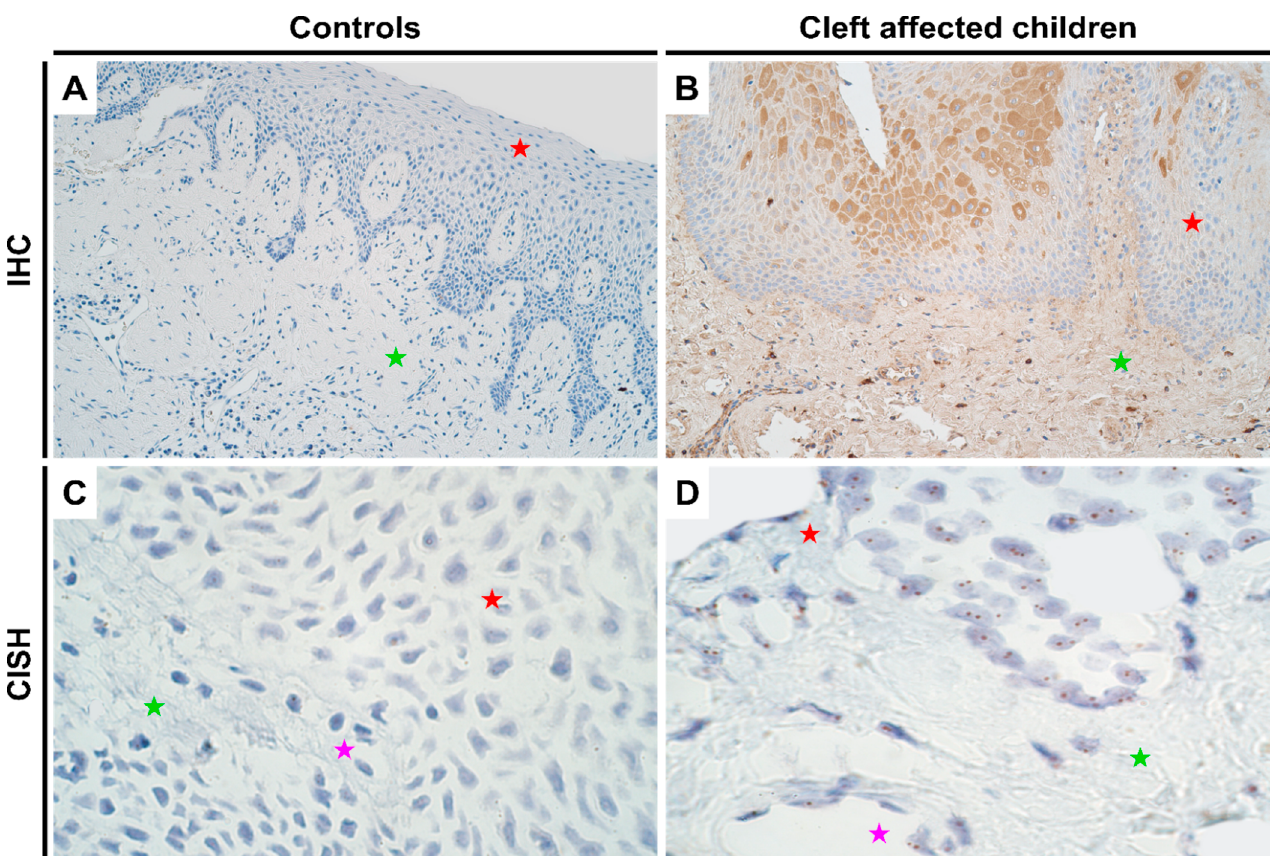
Figure 2. Expression of HOXB3 gene visualized using IHC and CISH methods in controls and cleft patients. Protein expression of the HOXB3 gene was visualized using immunohistochemistry (IHC) in ( A ) controls and ( B ) cleft affected children. ( A ) No positively stained (0) structures are visible in tissue obtained from controls; ( B ) Moderate number (++) of weakly stained epitheliocytes and connective tissue cells are seen in the cleft tissue obtained from a five-month-old girl. Original magnification, 200×. Gene amplification levels of HOXB3 gene was visualized using chromogenic in-situ hybridization (CISH) in ( C ) controls and ( D ) cleft affected children. ( C ) No gene amplification (0) is seen in the tissue obtained from controls; ( D ) No gene amplification (0) is seen; however, gene expression is seen by brown dots in the nucleus of the epithelial, endothelial, and connective tissue cells in the cleft tissue obtained from a three-month-old girl. Original magnification, 1000×. Red star indicates epithelium; green star indicates connective tissue, while purple star indicates endothelial cells.